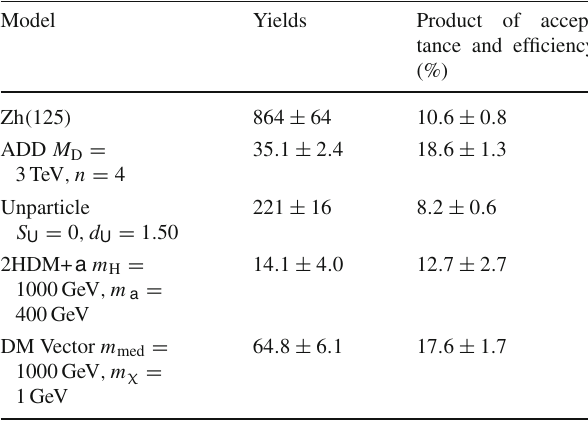
Table 4 Expected yields and the product of acceptance and efficiency for several models probed inthe analysis.The quoted values correspond to the Z → (cid:3)(cid:3) decays. The reported uncertainty represents the sum in quadrature of the statistical and systematic components Model Yields Product of accep- tance and efficiency